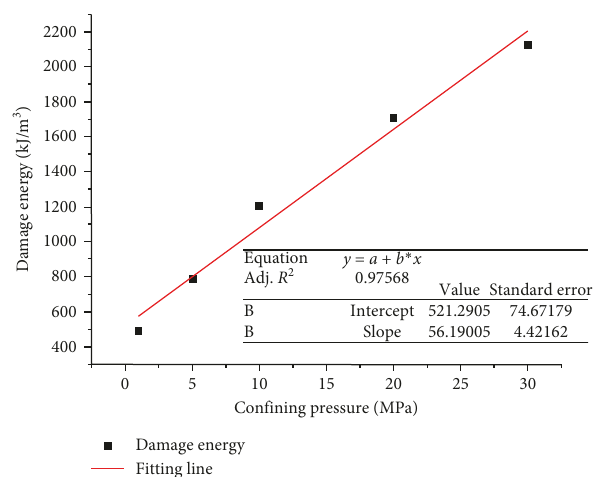
Figure 5: Confining pressure and damage energy of rocks fitting curve.